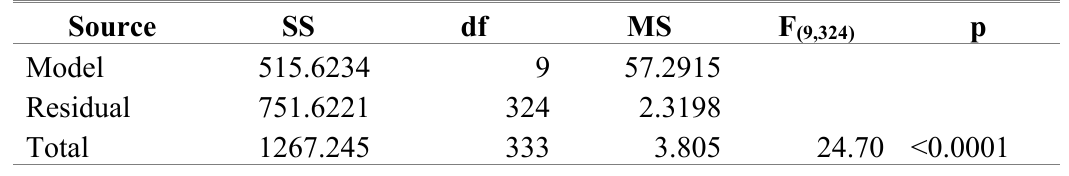
Table A1.3. Regression results for trust ecology